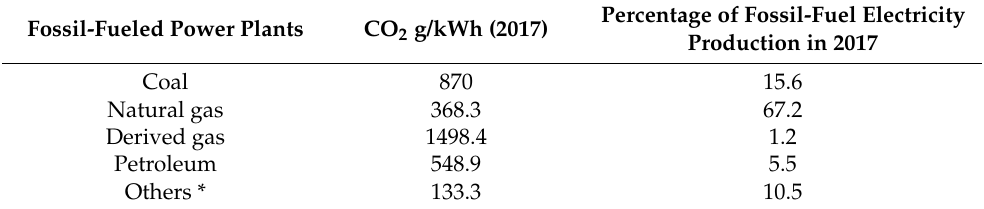
Table 6. CO 2 emission factors from fossil-fueled power plants in Italy